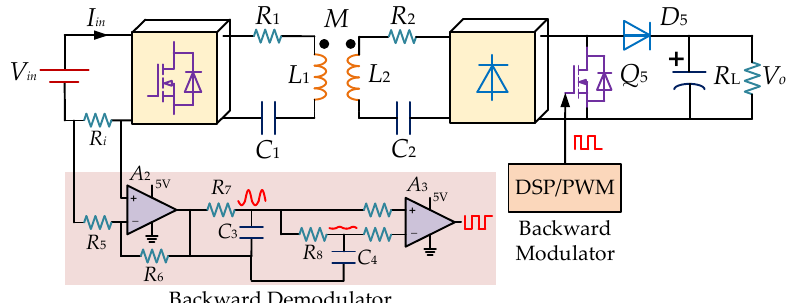
Figure 6. Structure diagram of information backward transmission.